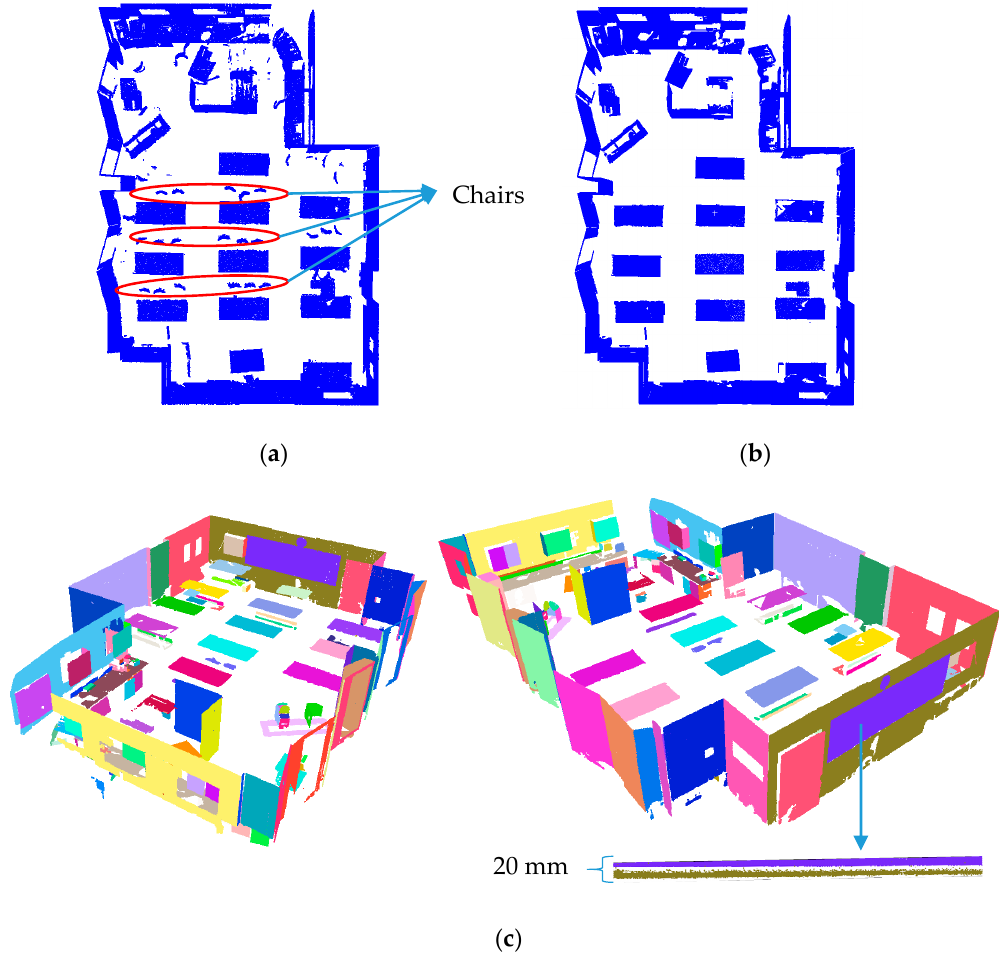
Figure 9. Planar classification of MML point cloud: ( a ) using only predefined thresholds of Equation (3); and ( b ) using outlier detection (Det-MCD) on the normalized eigenvalues of classified points of ( a ). ( c ) Robust planar segmentation of the classified planar points of ( b ).